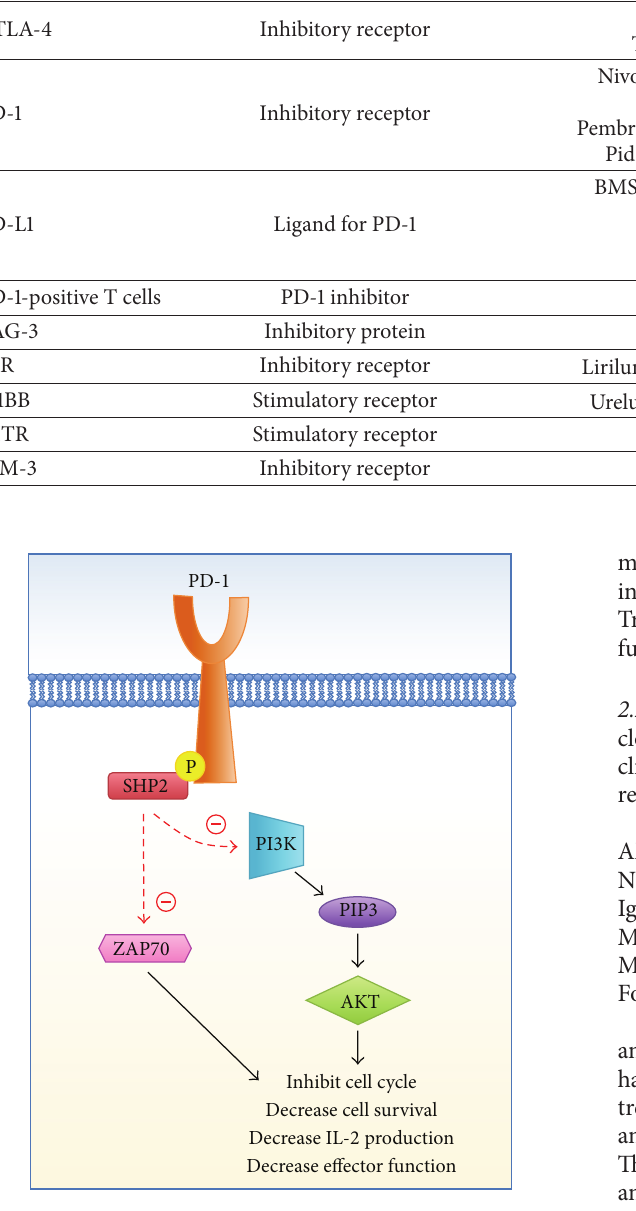
Figure 4: PD-1 signaling